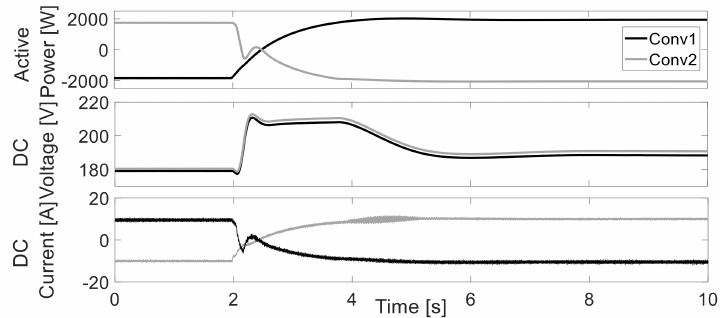
Figure 9. Experimental results of current reversal from − 10 A to 10 A with Conv1 in current control and Conv2 using P vs. V dc